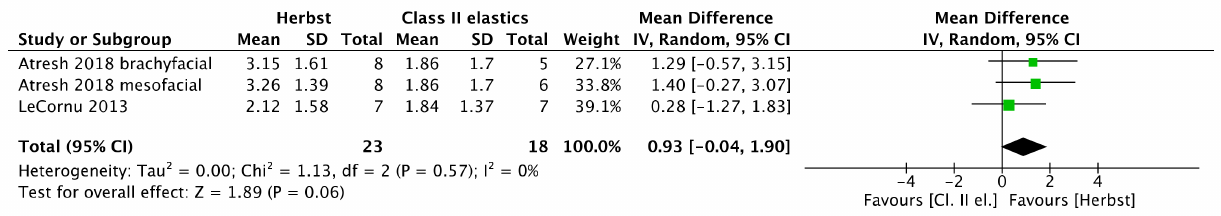
Figure 14. Forest plot of the right mandibular corpus length changes using the random effects model [43,44].